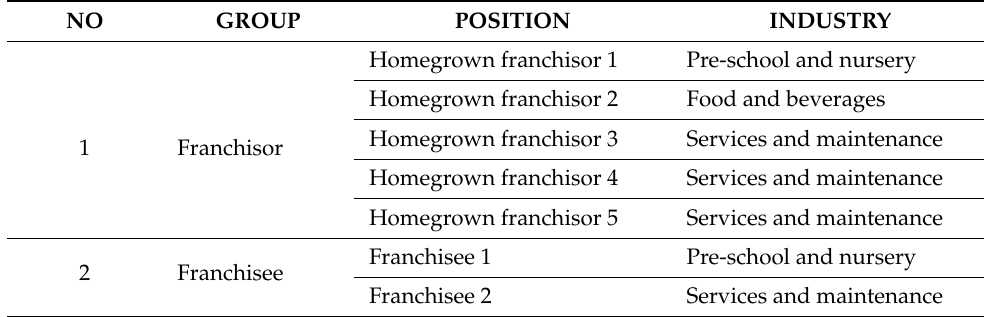
Table 1. Focus Group Discussion Participant.